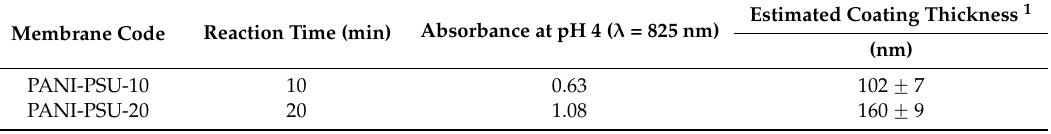
Table 1. Reaction conditions during the COP. Molar concentration of aniline was fixed to (0.05 M). The molar ratio of (aniline: APS) was fixed to (1:1.25). All reactions were carried out at room temperature using 1 M HCl as